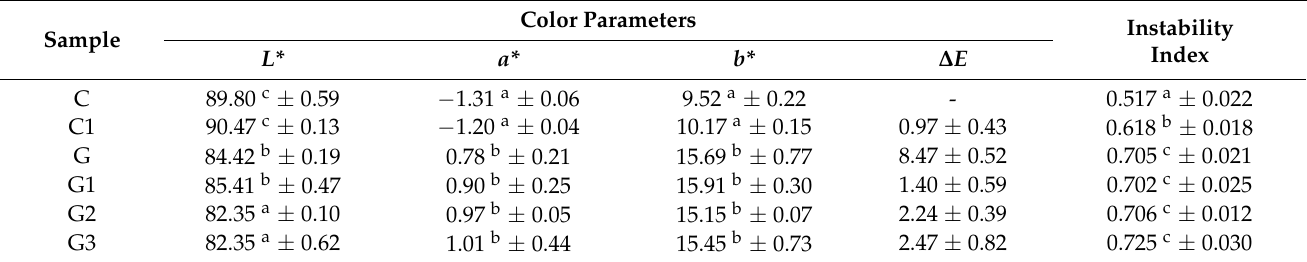
Table 2. Influence of the green tea addition on color parameters and the total color difference parameter of yoghurts. The abbreviations in the table refer to the control sample (C), control yoghurt with 6% inulin (C1), yoghurt with green tea (G), yoghurt with green tea and 3% inulin (G1), yoghurt with green tea and 6% inulin (G2), yoghurt with green tea and 9% inulin (G3). Color